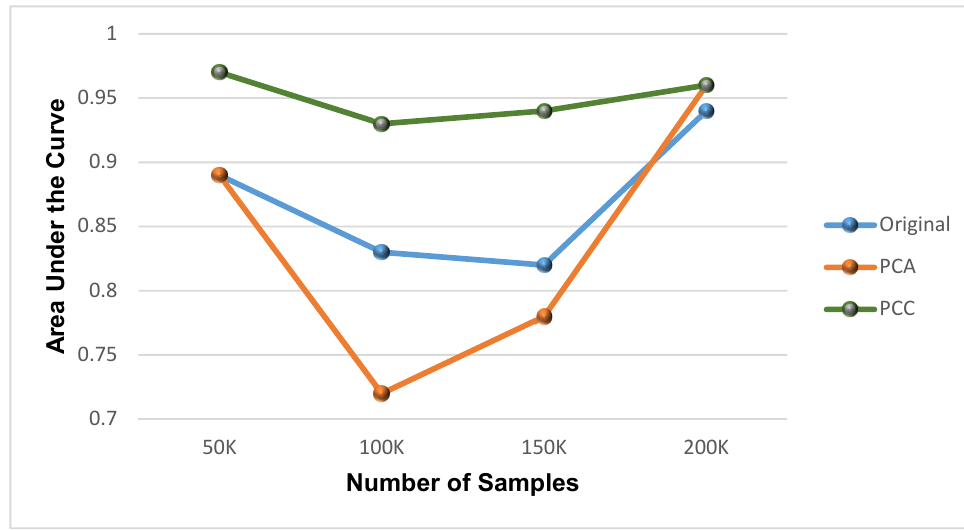
Figure 6. Comparison of PCC with PCA